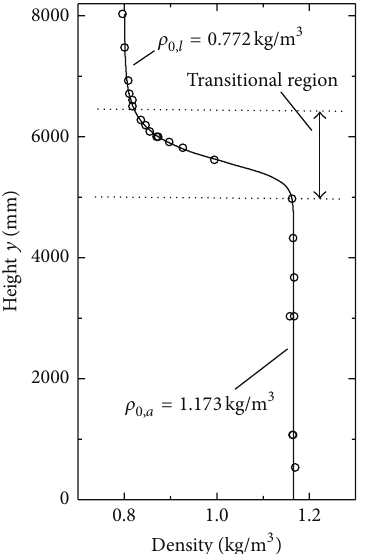
Figure 10: Initial gas density ( 𝑡 0 = 0 s) as a function of height in the vessel.